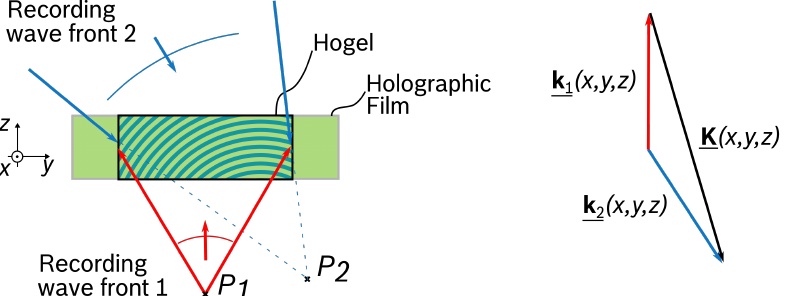
Figure 8. Schematic representation of the recording process for a single Hogel, governed by the two virtual point sources P 1 and P 2 . The Hogel’s volume holographic grating is described by the grating vector K , which is governed by the recording wave fronts characteristics described by k 1 and k 2 .